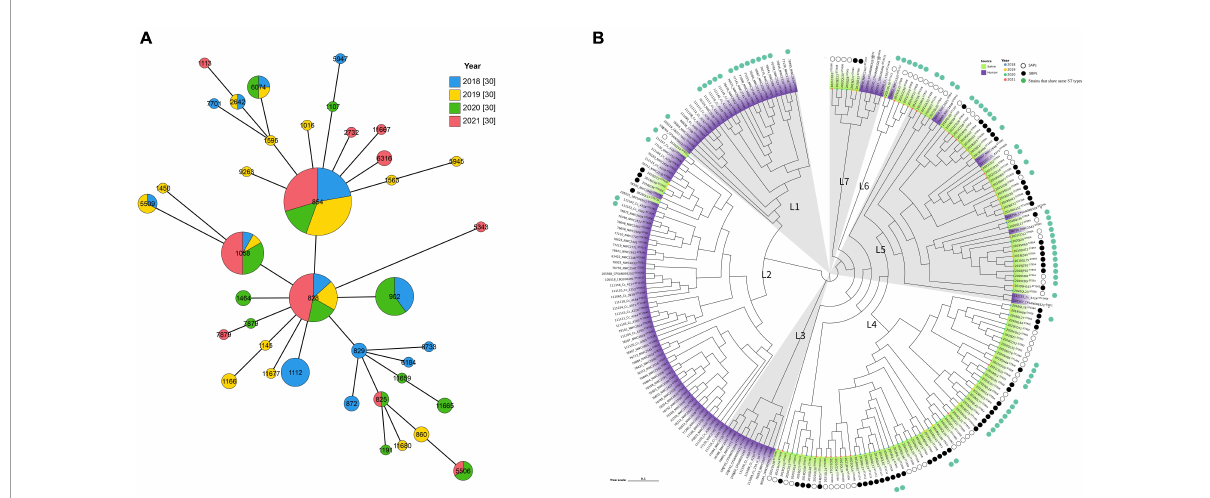
FIGURE3 Phylogenetic analysis of Campylobacter isolates. (A) ST typing of 120 Campylobacter isolates over 4 years. Blue: 2018 ( n = 30), Yellow: 2019 ( n = 30), Green: 2020 ( n = 30), and Pink: 2021 ( n = 30). Numbers in circles represent ST-types. (B) SNP phylogenetic tree of 120 swine-derived Campylobacter isolates and 105 human-derived Campylobacter isolates from a public database. The superscript means ST type; Purple: human-derived; Bright green: swine-derived; Black solid dots: SBPs; white hollow dots: SAPs; blue solid dots: same MLST types shared by swine- and human-derived Campylobacter